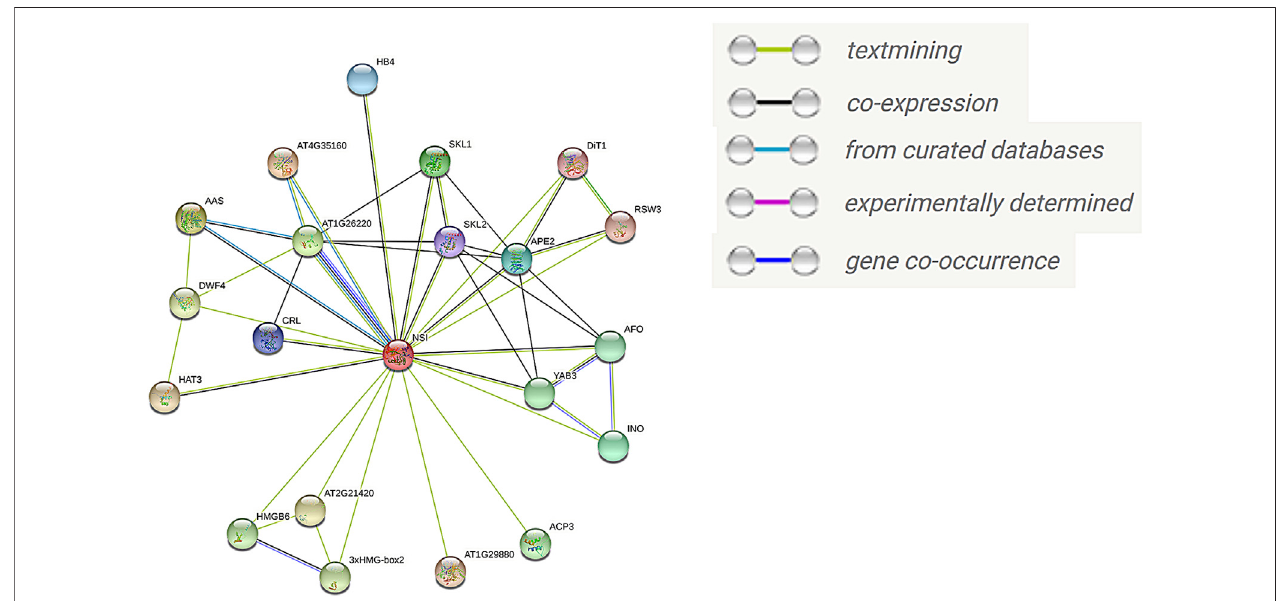
FIGURE 9 | The interaction network of GhSNAT